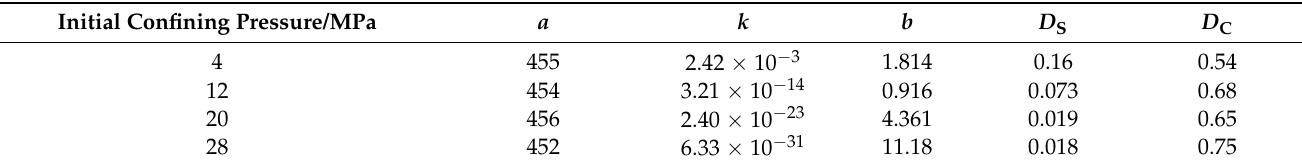
Table 2. Fitting results of deformation modulus under different confining